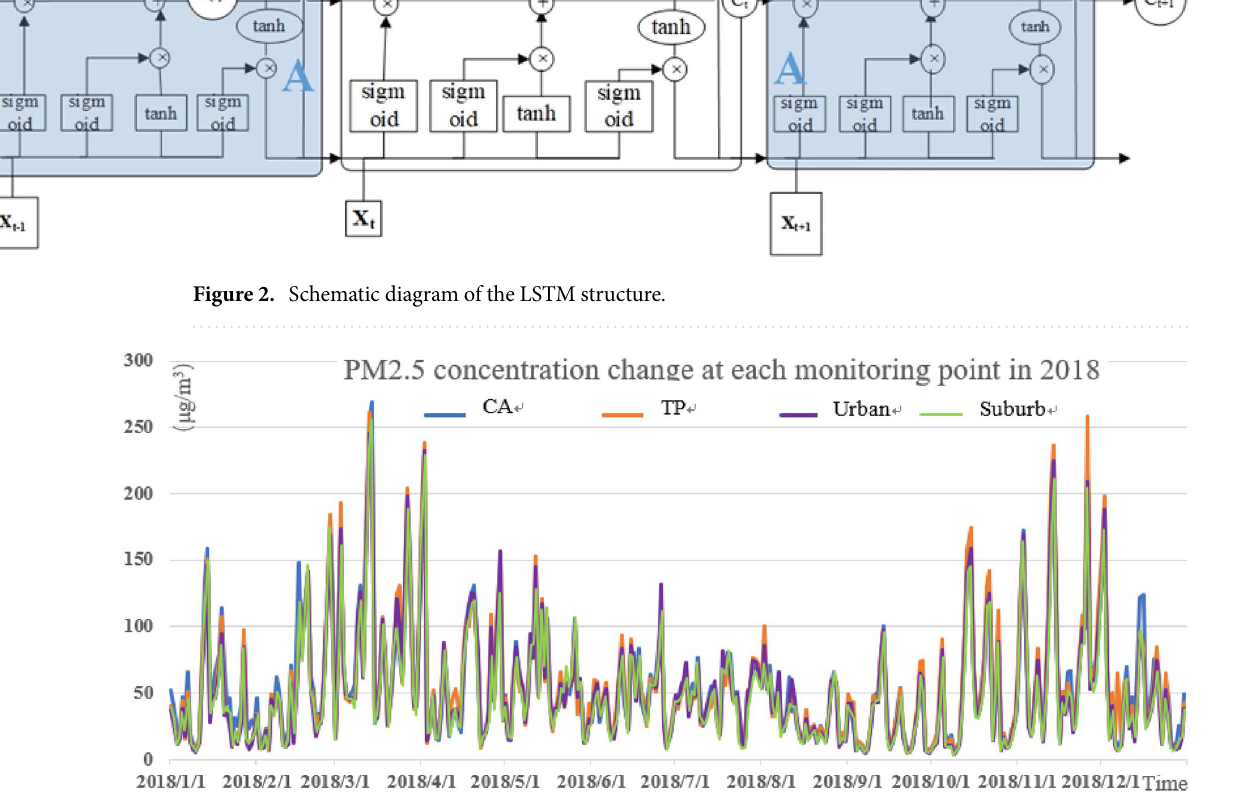
Figure 3. PM 2.5 concentration change at each monitoring point in